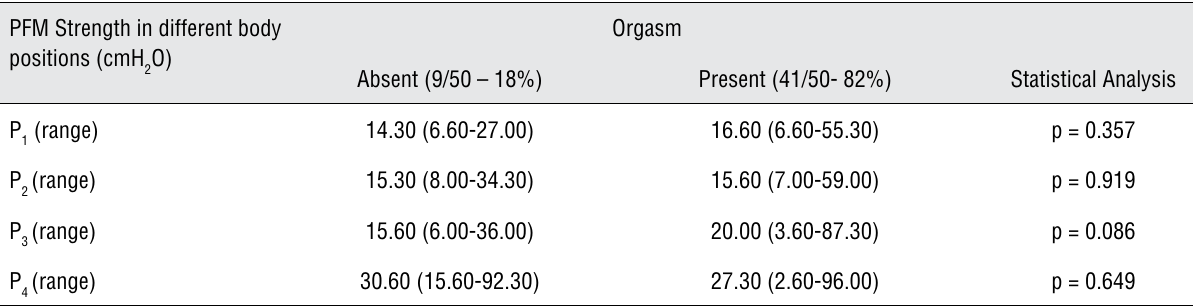
Table 3 - Association between Maximum amplitude (cmH of PFM strength using perineometer in different positions and presence or not of